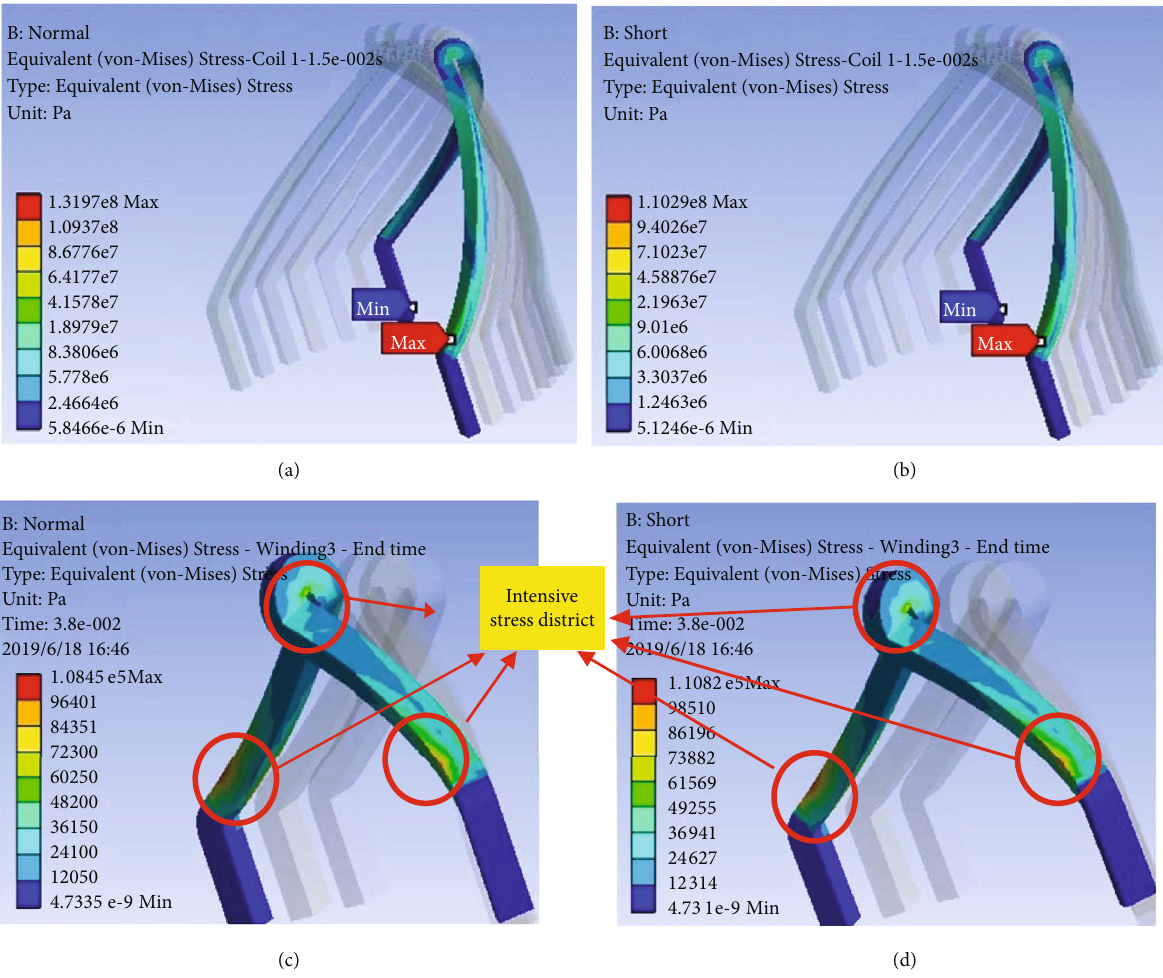
Figure 10: Stress distribution before and after RISC: (a, b) QFSN-600-2YHG generator in normal and RISC, respectively; (c, d) MJF-30-6 simulator in normal and RISC,